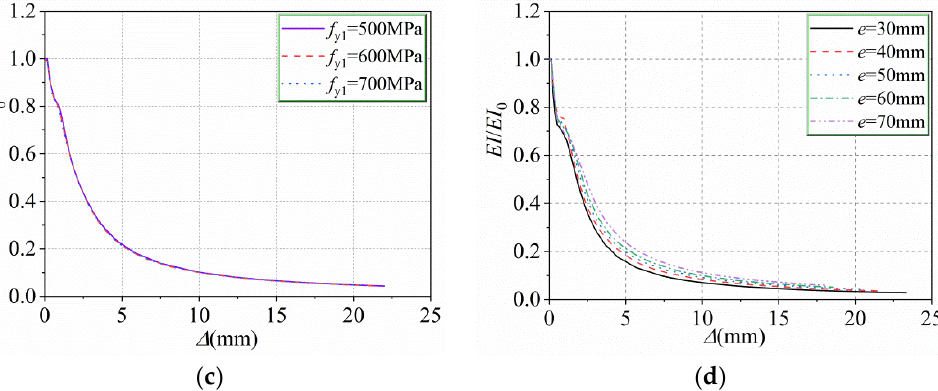
Figure 14. Stiffness degradation curves under different parameters: ( a ) f y ; ( b ) t ; ( c ) f y1 ; ( d ) e .